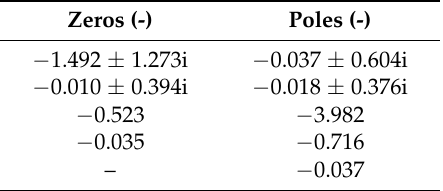
Table 2. Identified transfer function of the single-input single-output (SISO) system.